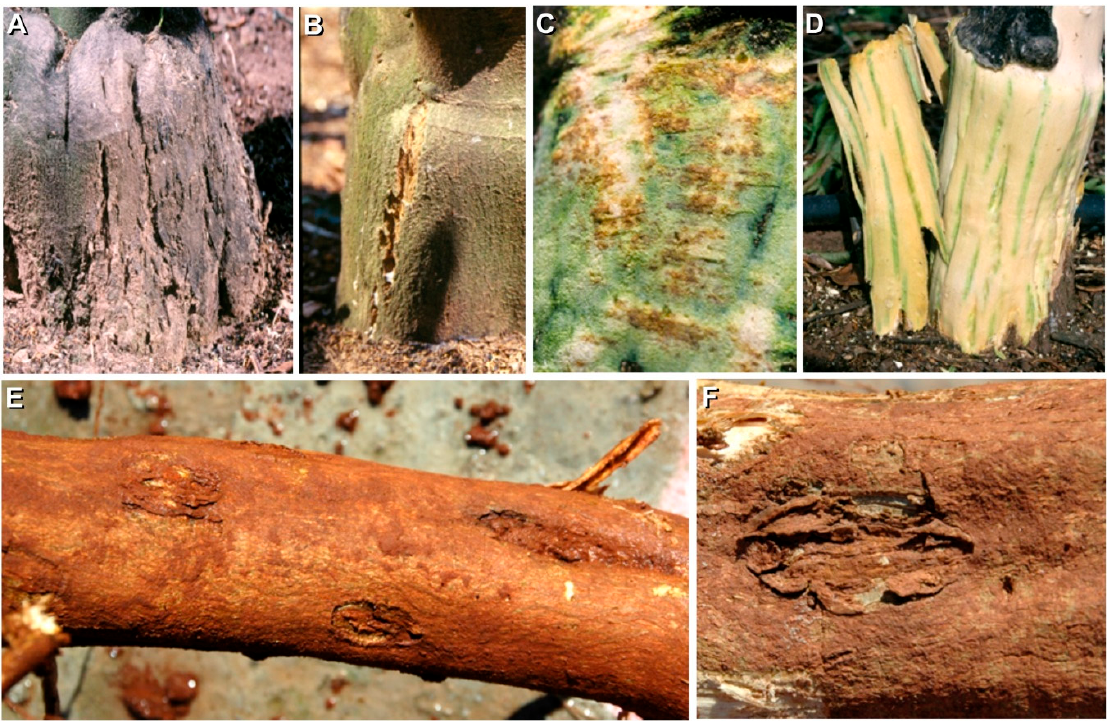
Figure 4. Characteristic symptoms as a result of viroid infection in plants grafted on trifoliate orange: Bark scaling induced by CEVd in trifoliate orange ( A ); bark cracking induced by Citrus bark cracking viroid (CBCVd) in trifoliate orange ( B ); wood pitting and gum deposits in the clementine scion caused by cachexia strains of HSVd ( C ); green streaks under the cracks induced by CBCVd in trifoliate orange ( D ). Lesions in the roots caused by CEVd in Citrange carrizo roots ( E , F ).